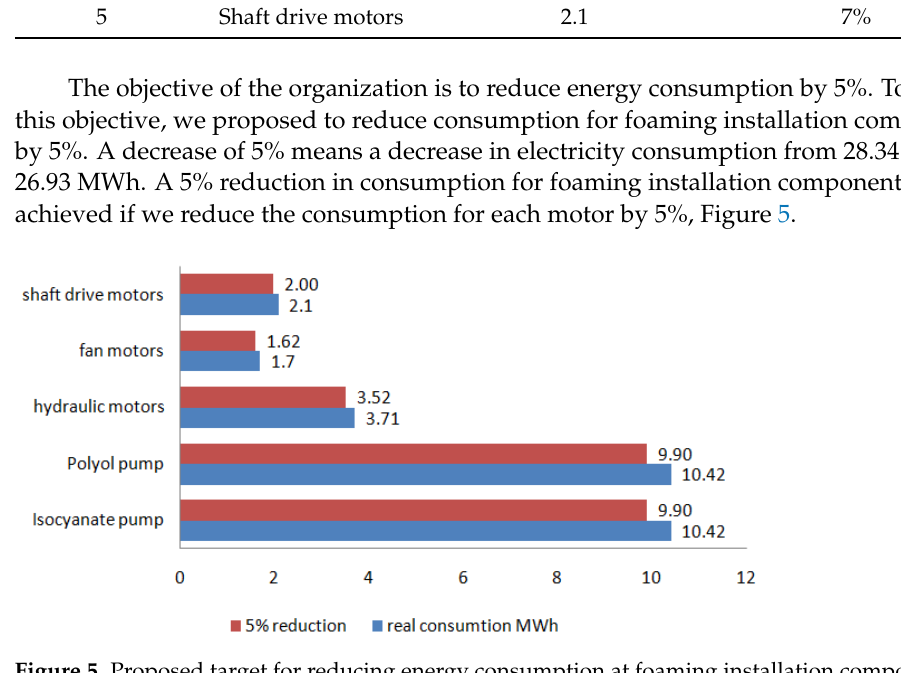
Figure 5. Proposed target for reducing energy consumption at foaming installation component 1.